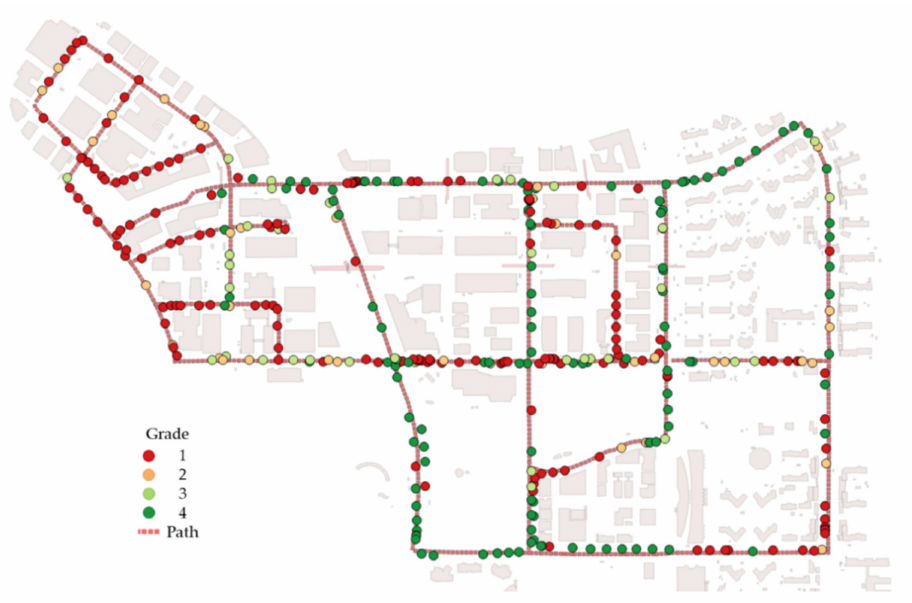
Figure 10. Distribution of grades 1 to 4 at the observation positions.